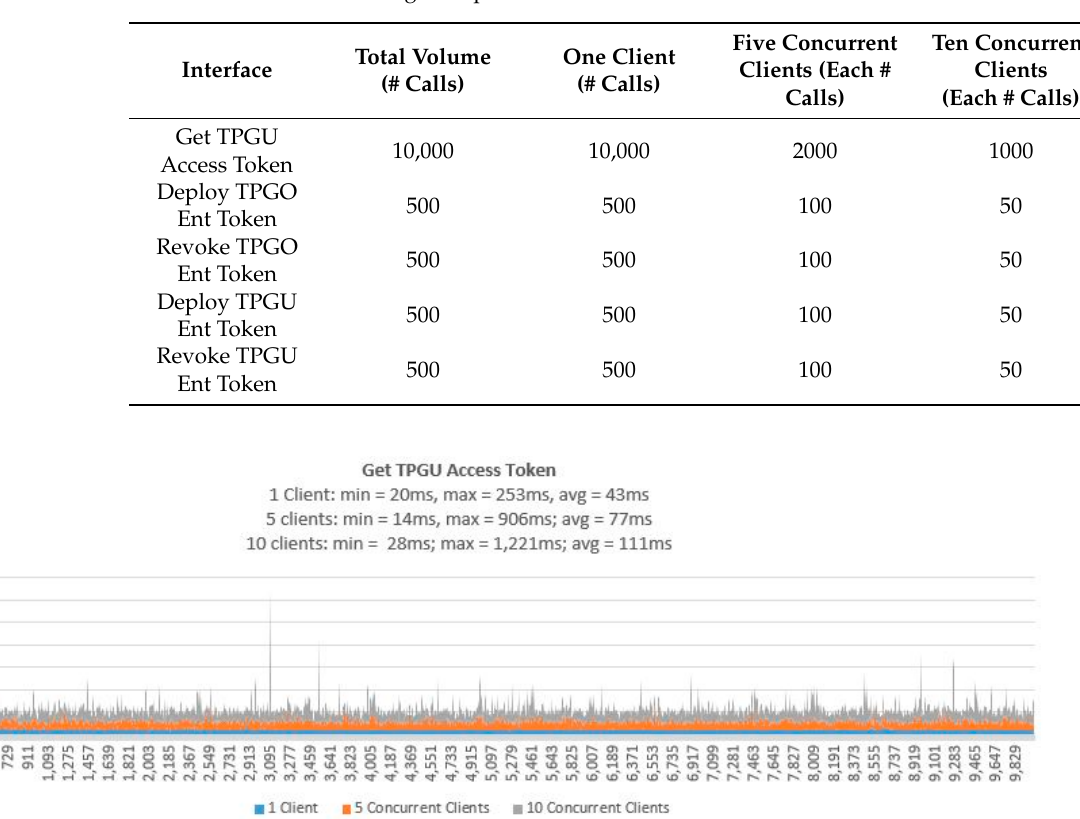
Table 6. Performance Testing Set-ups.